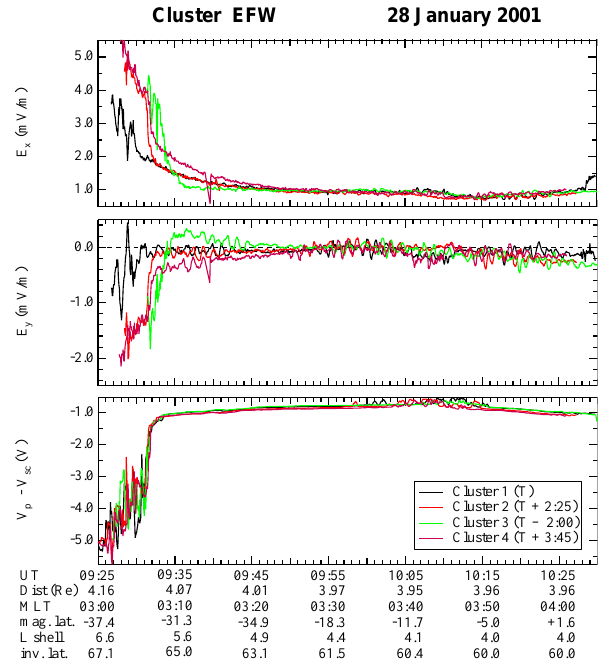
Fig. 5. Observations by the EFW experiment in the inner magneto- sphere on 28 January 2001, 09:25–10:30 UT. The two electric field components in the field line coordinate system and the differential potential measurements are shown. The plasmapause is crossed by Cluster1 at ∼ 09:32 UT and by the other three spacecraft within ± 4 min of that time, as shown by the legend in the bottom